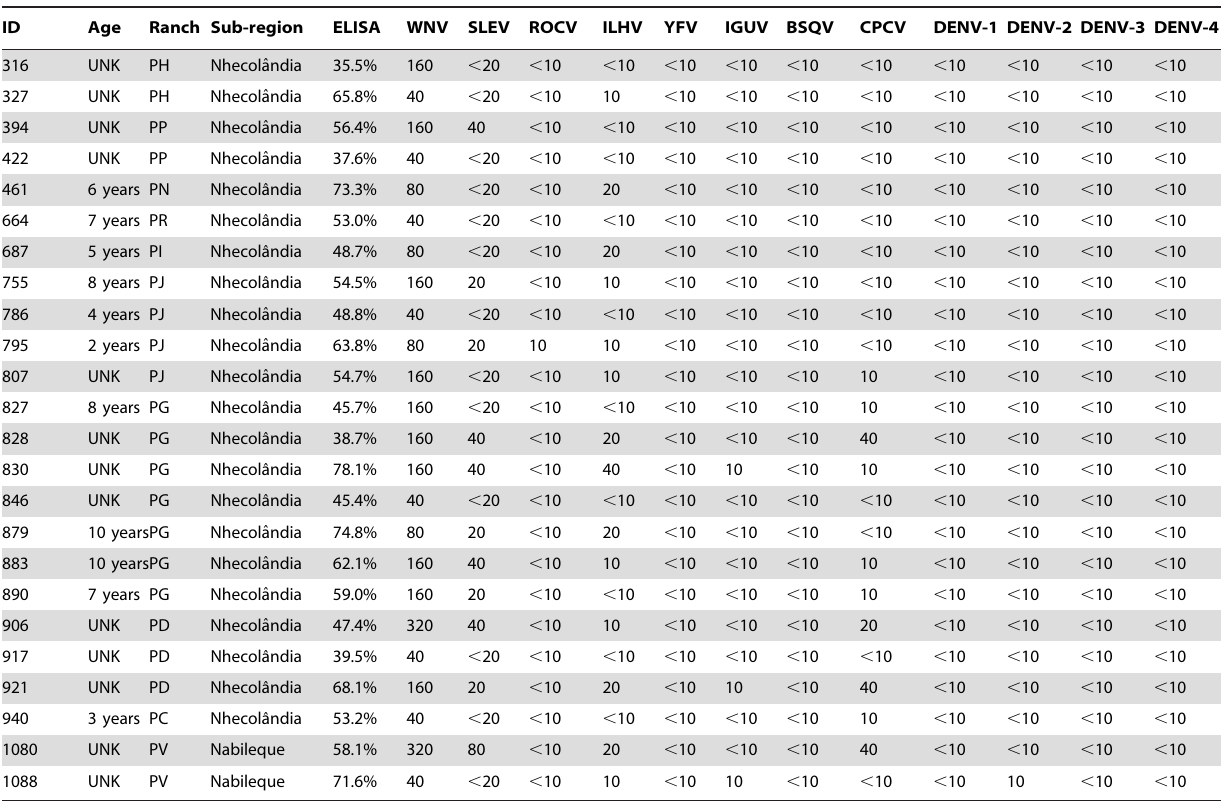
Table 2. Comparative PRNT 90 titers for 12 flaviviruses among 24 WNV-seropositive equines of the Pantanal,